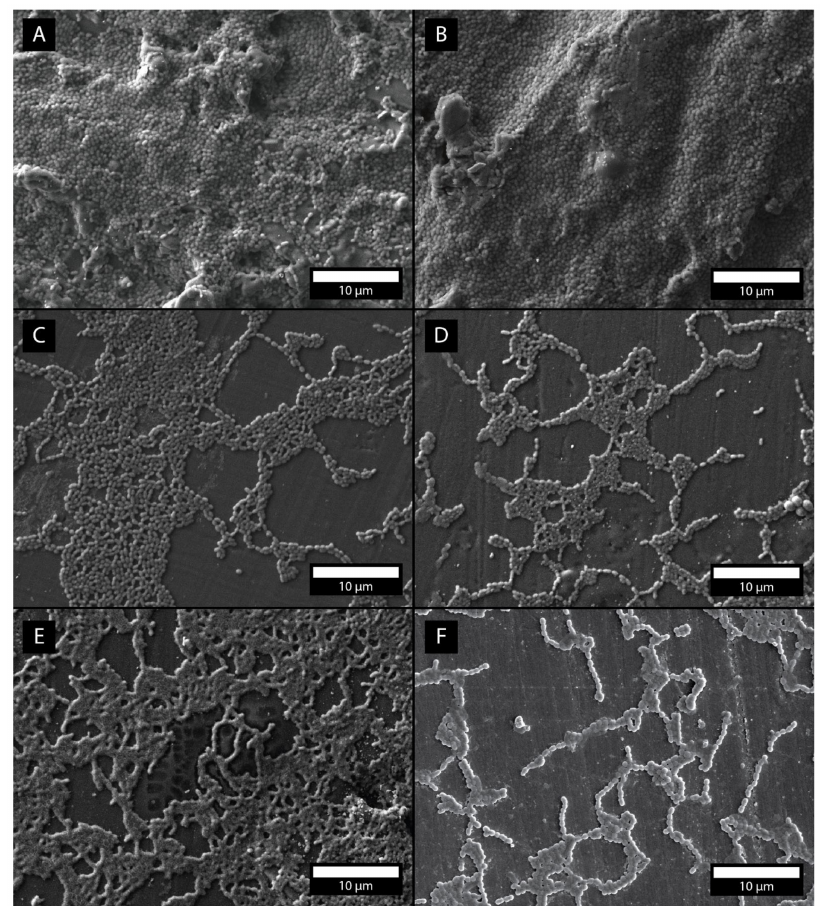
Figure 5. SEM micrographs with adhered bacteria S. mutans for all five PMMA surfaces. ( A ) 0%,